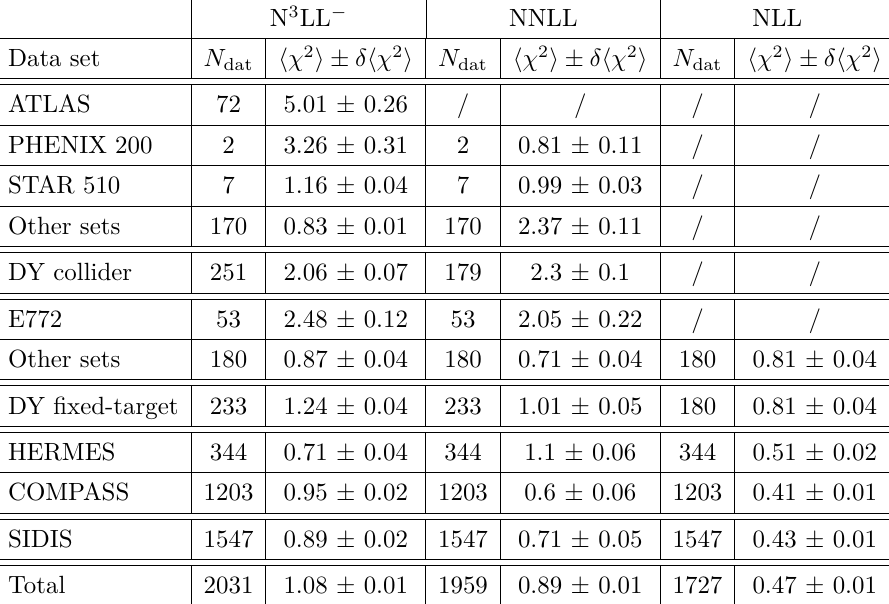
and δ are the average and standard deviation of the χ 2 values χ 2 χ 2 h i h i